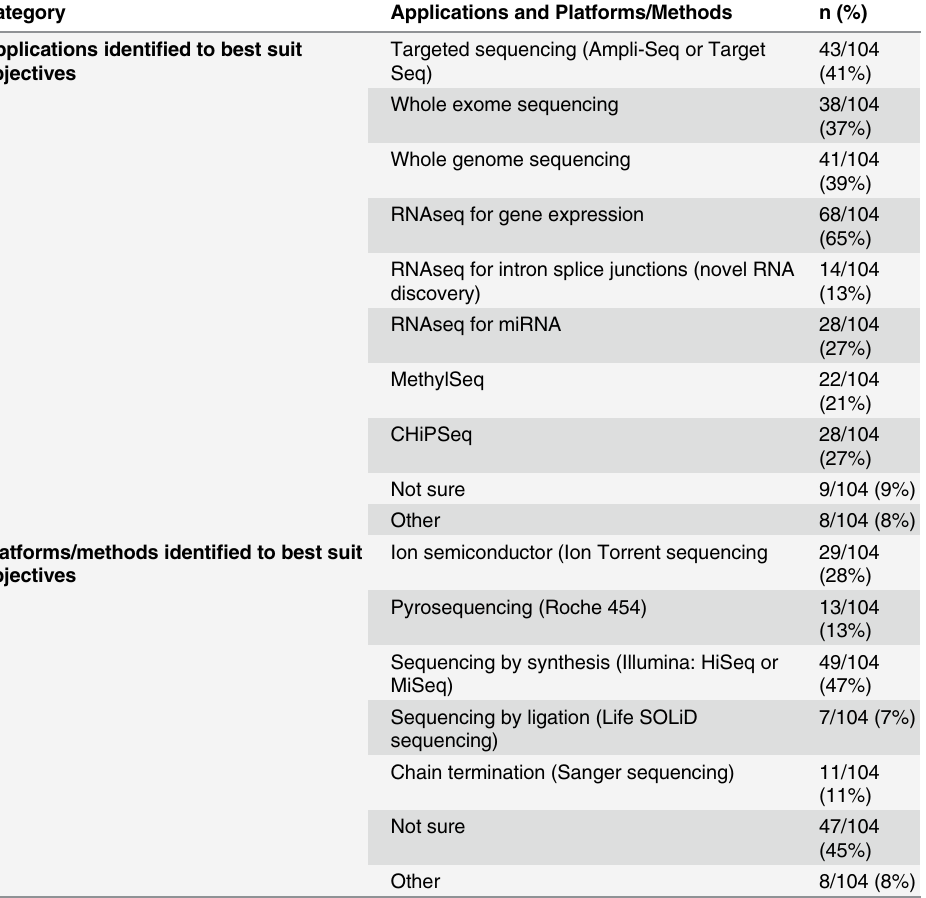
Table 5. Applications and platforms/methods identified as best to suit objectives ( All Users